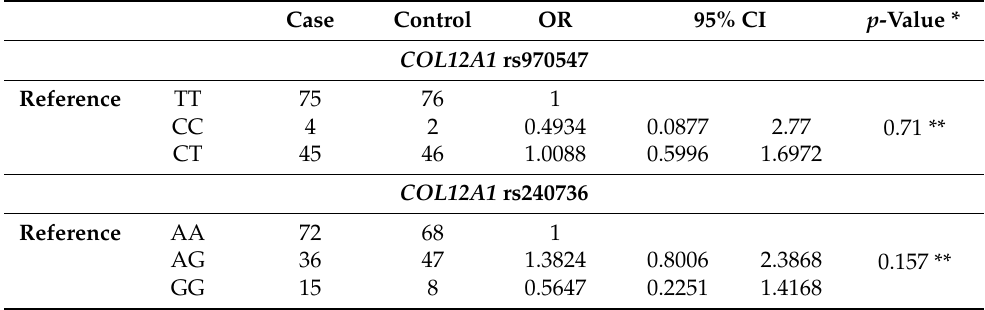
Table 2. Odds ratio analysis.